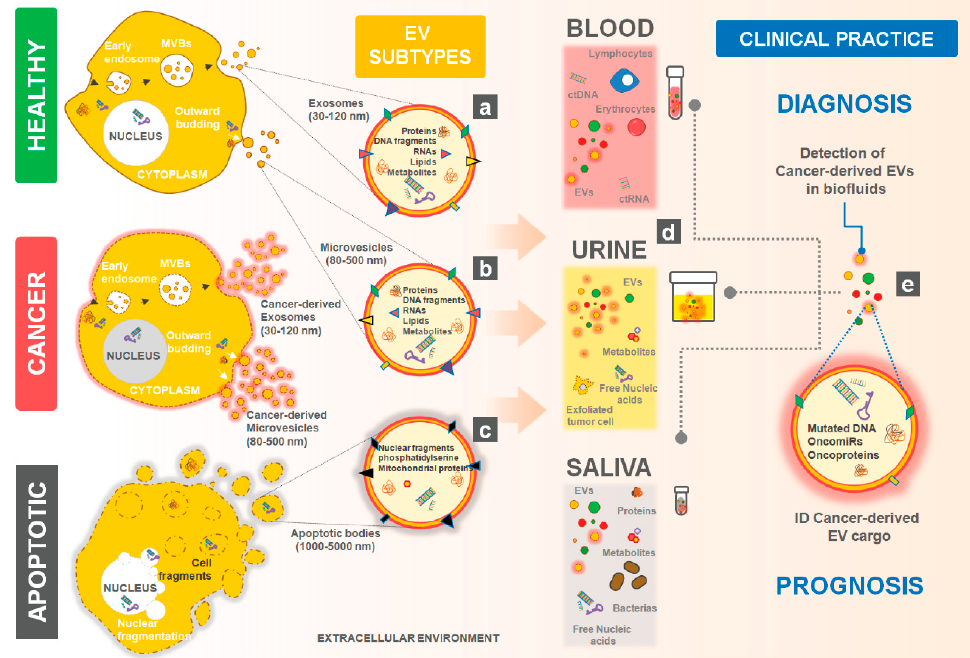
Figure 1. Features of Extracellular Vesicle (EV) sub-populations. EVs are comprised of a heterogeneous group of lipid membrane enclosed vesicles produced by virtually all cells of the organism. EVs play a key role in intercellular communication to support homeostasis or cancer progression. Importantly, this heterogeneous group of EVs may include ( a ) exosomes with a size range between 30 – 120 nm that originate via the endosomal system, ( b ) microvesicles with a size range between 80 – 500 nm that derive from the outward budding of the cells’ plasma membrane and even ( c ) apoptotic bodies that are secreted during the fragmentation of apoptotic cells. Upon secretion to the extracellular environment, exosomes and microvesicles have overlapping size range and share many markers (e.g. CD63, HSP70, CD9, CD81) while apoptotic bodies are characterized by an enrichment of phosphatidylserine on their surface. The similar features between exosomes and microvesicles make an accurate discrimination of EV origin very difficult when these subpopulations are mixed in complex biofluids. ( d ) The cancer-derived EVs are highly abundant in biological fluids such as blood, urine and saliva, and their surface immunophenotypic protein markers reflect the cell of origin. In clinical practice, ( e ) the detection of cancer-derived EVs in the biological fluids of patients can be explored for the disease diagnosis, while the EV cargo characterization also provides important clues on the disease prognosis.